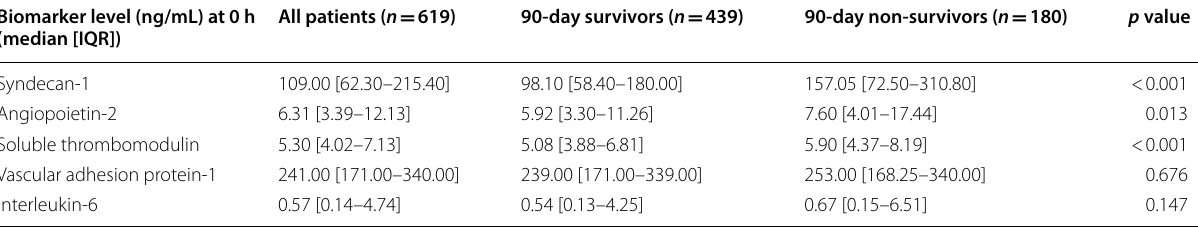
Table 5 Biomarker levels in all patients and according to 90-day mortality Biomarker level (ng/mL) at 0 h (median